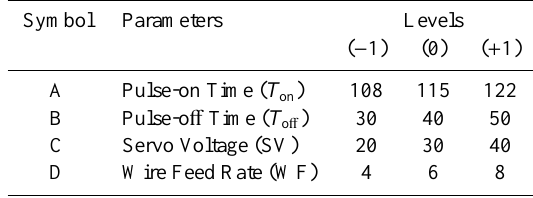
Table 1. Process parameters and their levels.